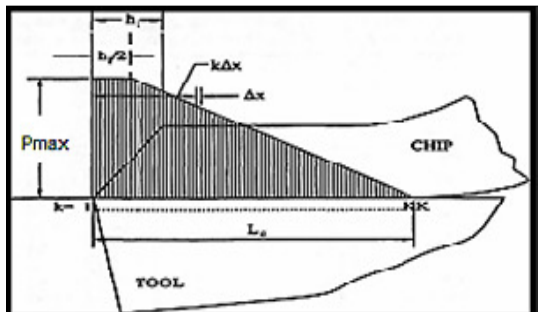
Fig. 2 . Distribution of friction power over the rake face of the tool [11].